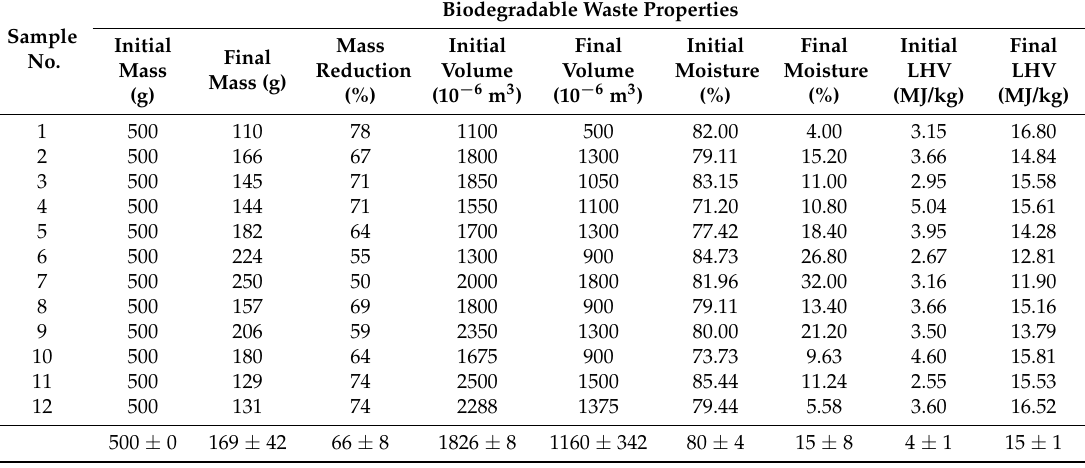
Table 2. Properties of the biodegradable waste samples of Myanmar before and after drying at 105 ◦ C for 5 h.